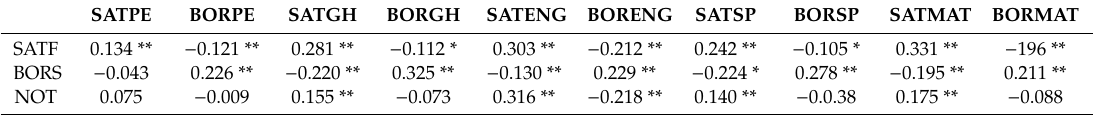
Table 4. Correlation between satisfaction in subjects, students, and academic grades.